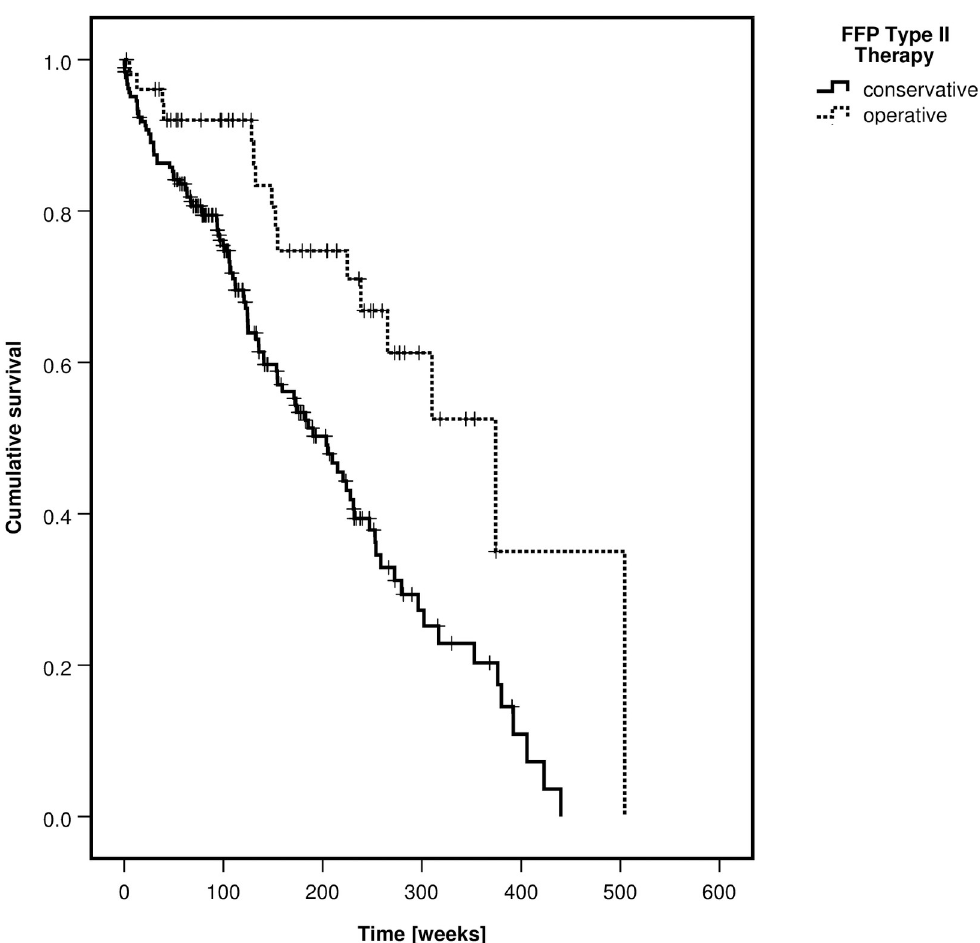
Fig 5. Kaplan-Meier curve of cumulative survival, depending on type of treatment—FFP type II patients.